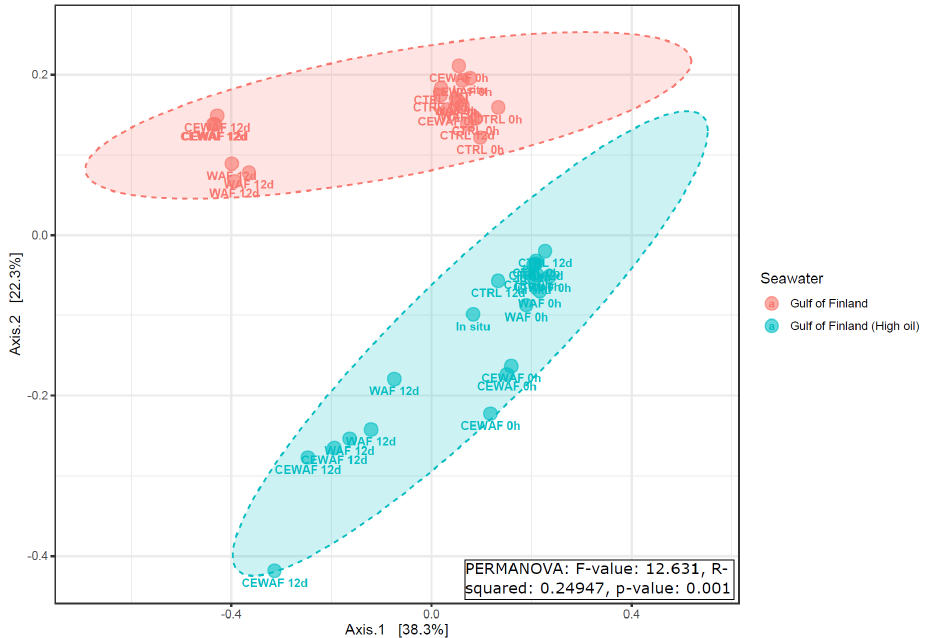
Figure 5. Principal coordinates analysis (PCoA) of microbial communities comparing different mi- crocosm experiments. PCoA was based on a Bray–Curtis distance matrix using genera data.